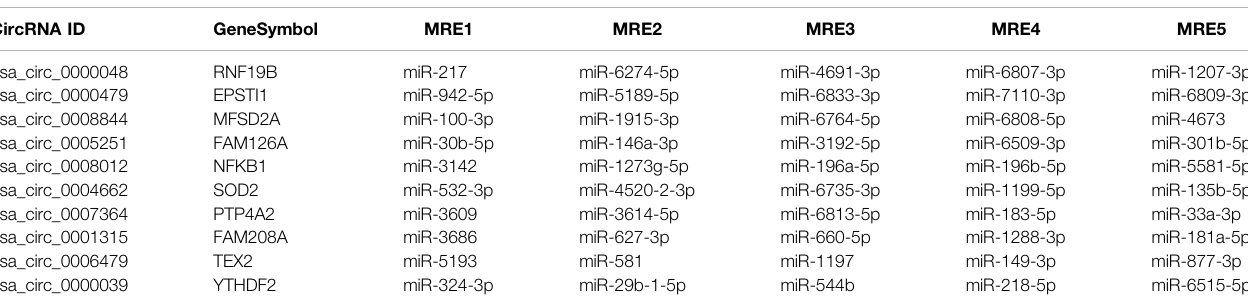
TABLE 2 | Annotation for differentially expressed circRNA/miRNA